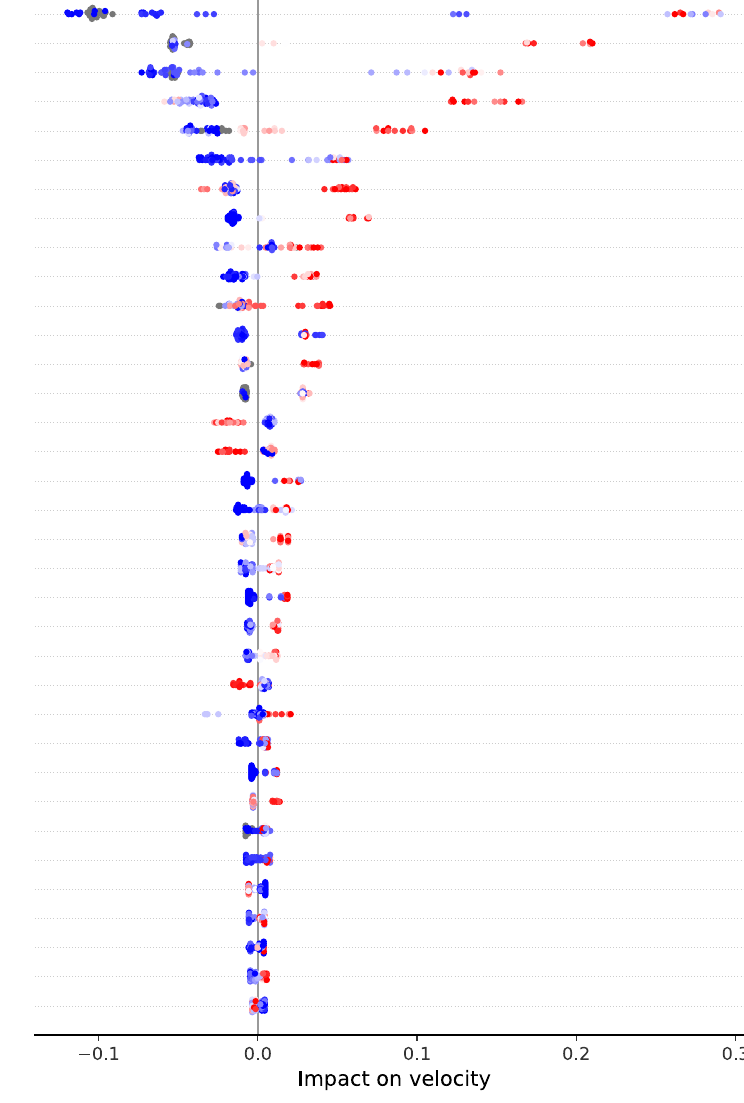
Fig 43. (Color online) summary plot showing how each factor contributes to increase/decrease velocity at the peak of velocity.